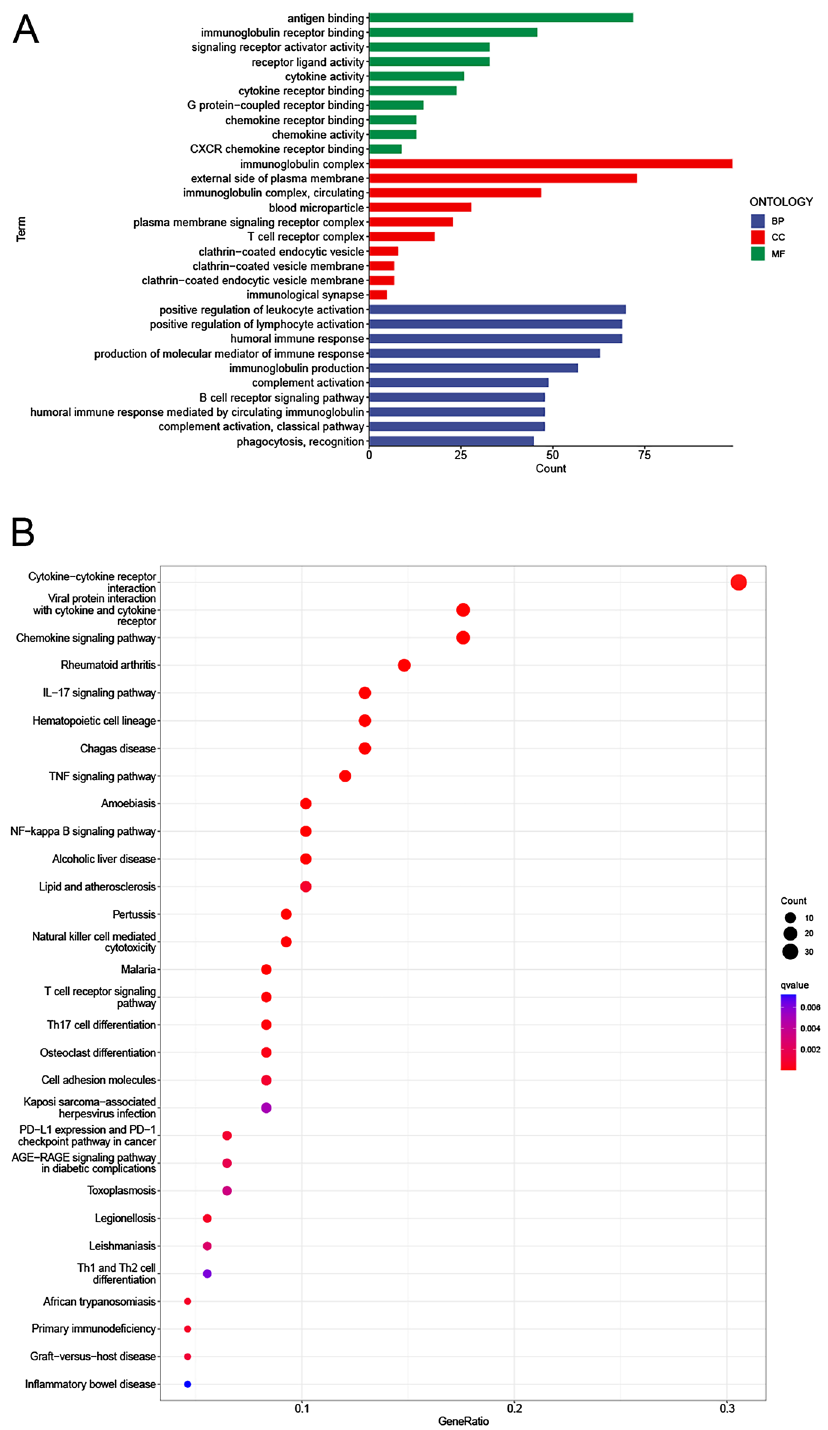
Figure 10. Functional enrichment analysis between the high and low risk groups of CESC patients. ( A ) Results of the GO enrichment analysis. ( B ) Results of the KEGG enrichment